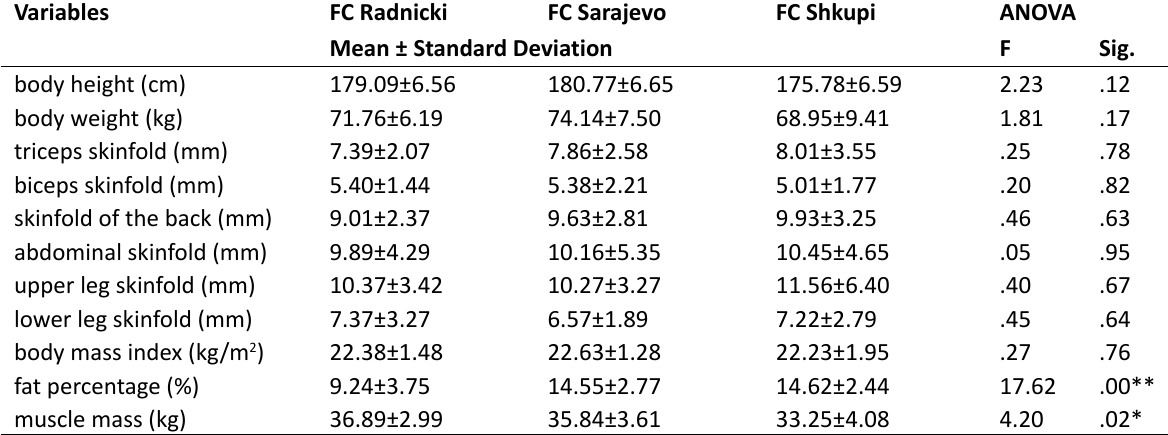
Table 1. Descriptive data and ANOVA of 51 young soccer players, members of the three clubs